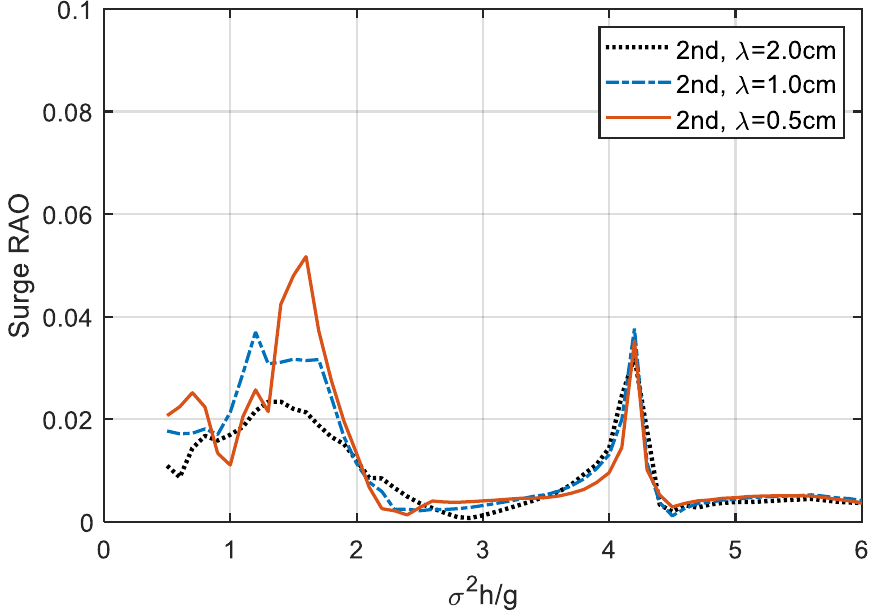
Figure 12. Comparison of the second-order surge RAO of the floating platform with different fishnet mesh sizes.